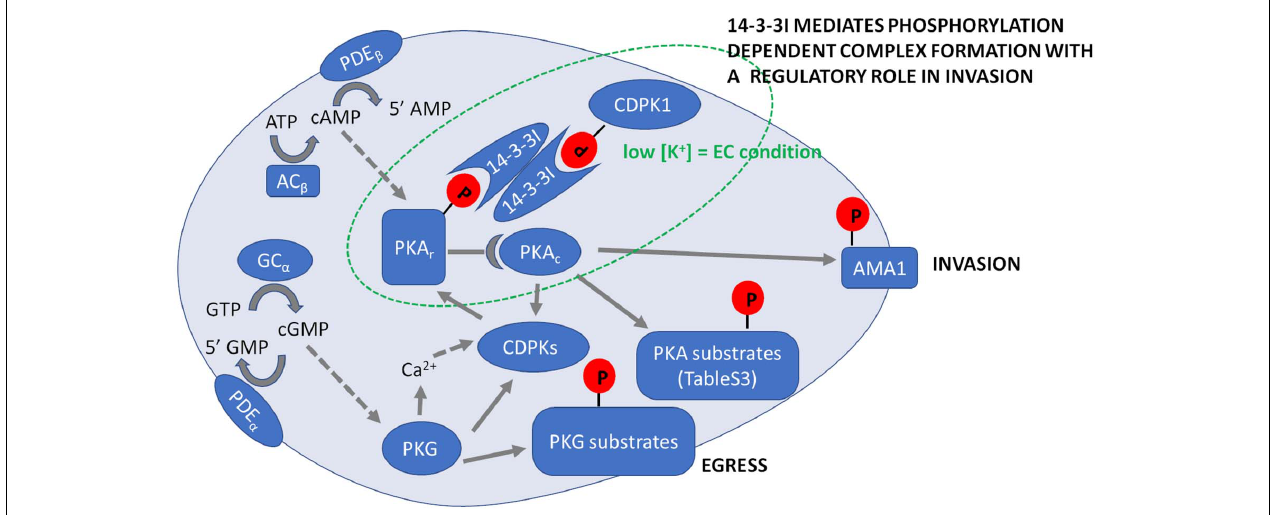
FIGURE 5 | Summary of Plasmodium falciparum cyclic nucleotide signaling during erythrocyte invasion. Prior to merozoite egress PKG is activated by binding cGMP, which is produced by the conversion of GTP to cGMP by GC. Activation of PKG induces an increase in intracellular Ca 2 + and activation of calcium-dependent kinases (CDPKs), which leads to secretion of apical proteins leading to egress of merozoites from mature schizonts. Egressed merozoites in extracellular ionic conditions (EC) with low K + levels activate AC β that converts ATP to cAMP. PKAr, the regulatory subunit of PKA binds cAMP releasing the catalytic subunit PKAc to phosphorylate specific target substrates that are listed in Supplementary Table 3 . In extracellular merozoites PKA phosphorylates S590 in the cytoplasmic tail of AMA1 and we hypothesize it locks AMA1 in an invasion competent conformation provoked by PKA-mediated S610 phosphorylation of AMA1 prior to merozoite release from red blood cells. Following merozoite egress, phosphorylation of both PKAr and CDPK1 increases to promote their binding to 14-3-3I, so forming a multi-protein complex mediating secretion of microneme proteins such as AMA1 required for invasion. Phosphorylation of targets by various kinases is indicated by solid arrows. Activation of kinases by second messengers is indicated with dotted arrows. Cyclic nucleotides are hydrolyzed by PDE α and PDE β .